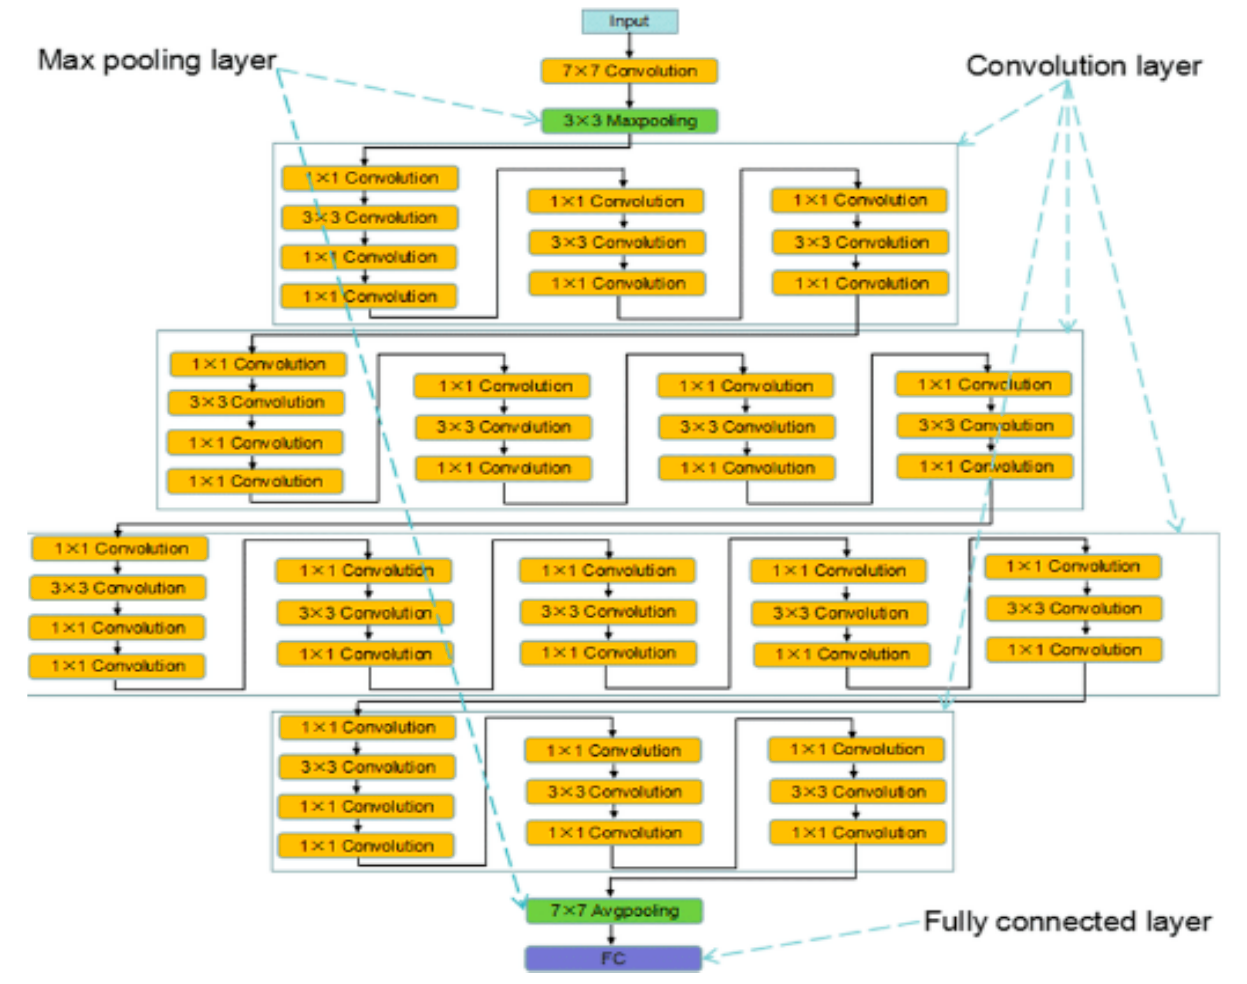
Figure 6. ResNet50 model architecture.